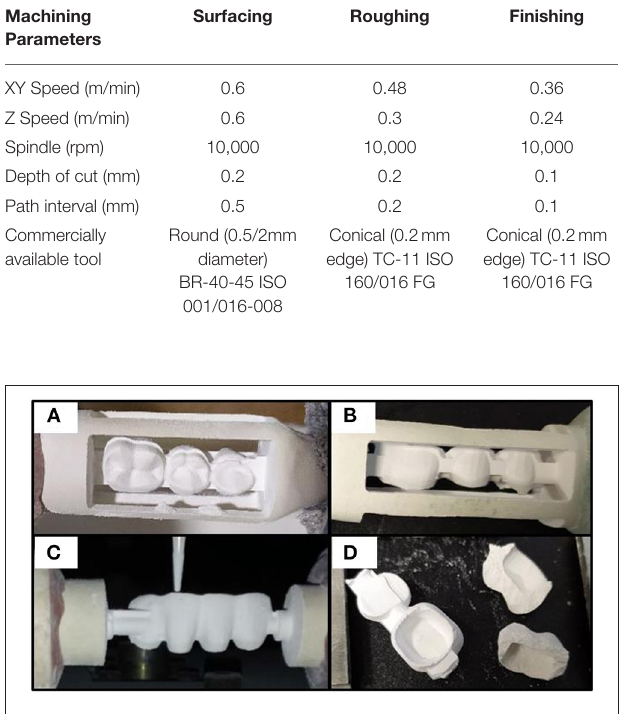
TABLE 1 | Parameters used for green machining of ceramic blanks. Machining Parameters